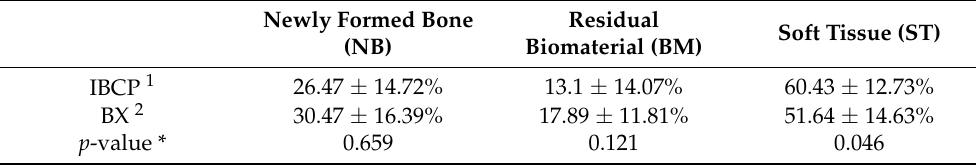
Table 3. Histomorphometrical